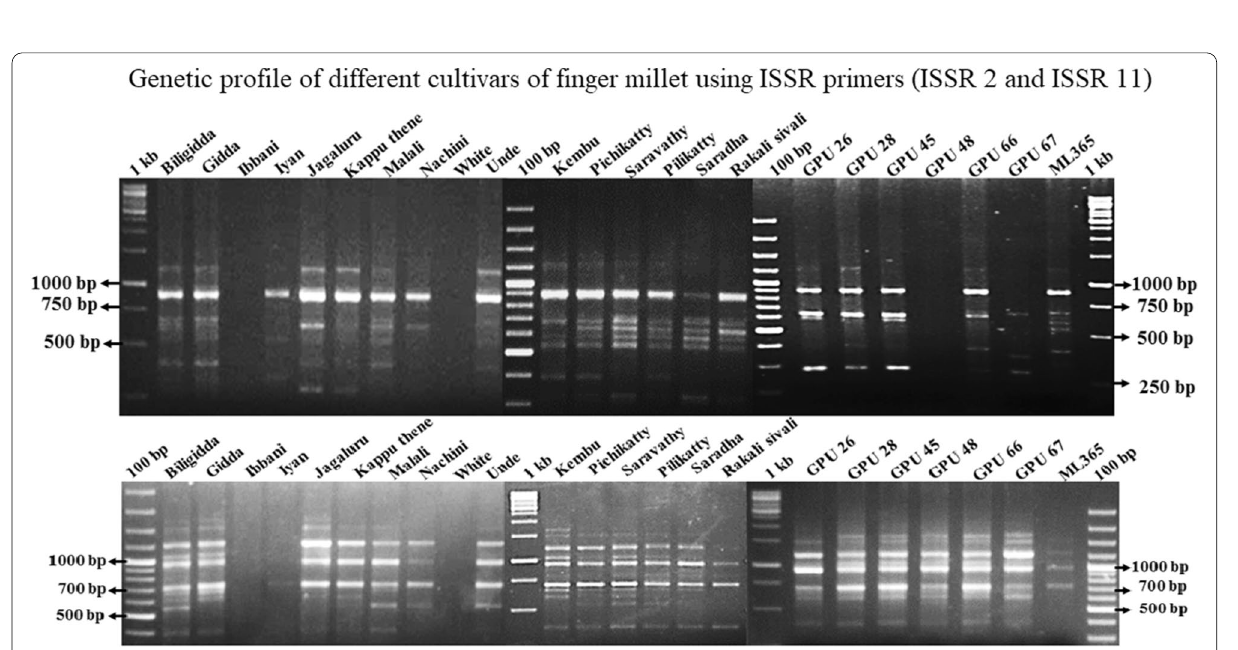
Performance of ISSR marker PIC value of each primer was calculated according to [27] and the mean value of PIC for all the loci of each primer was analyzed. The range of PIC value for all the 173 polymorphic loci was 0.20–0.96 with a mean of 0.36. Of 15 primers, two of them (ISSR 9 and ISSR 11) were highly informative (PIC value > 0.5) and 12 ISSR